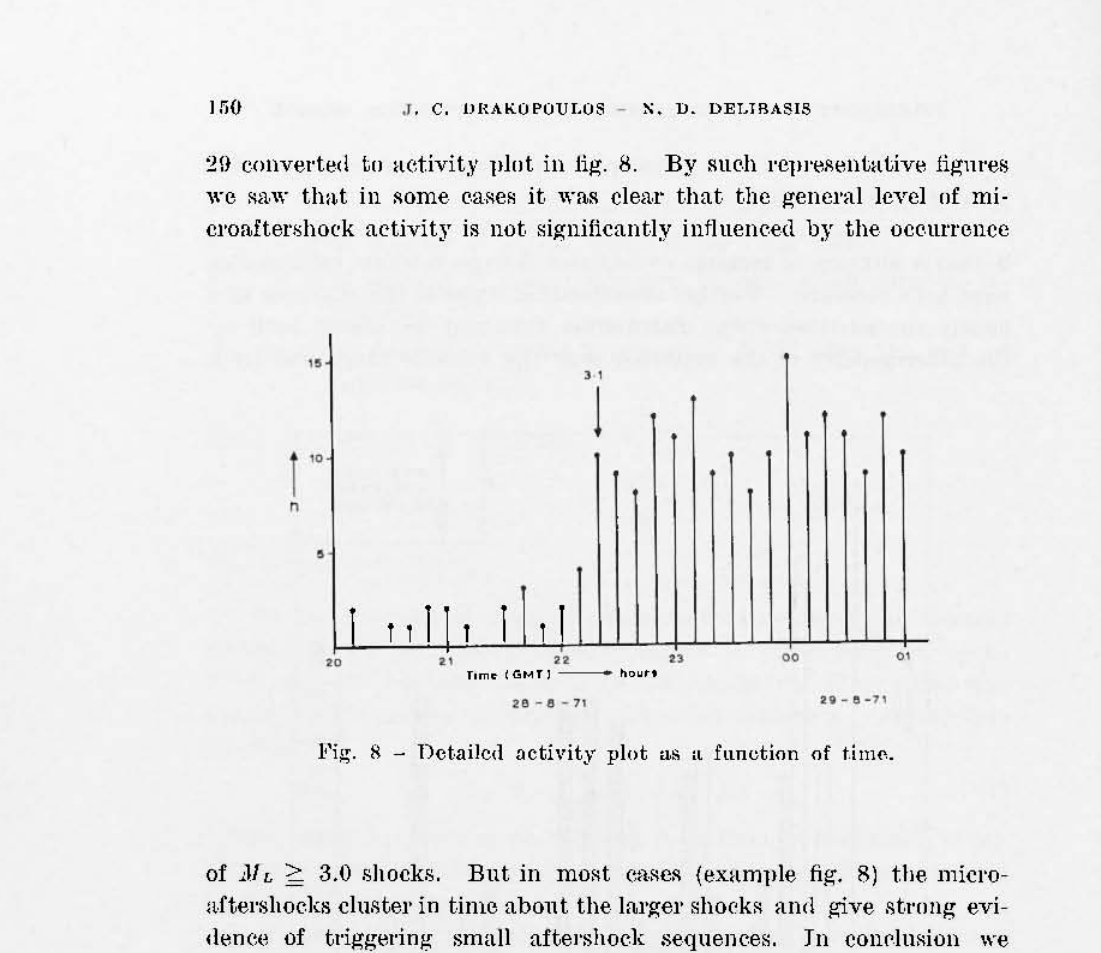
Fig'. 8 - Dctailcd activity plot aB a ftlnction of